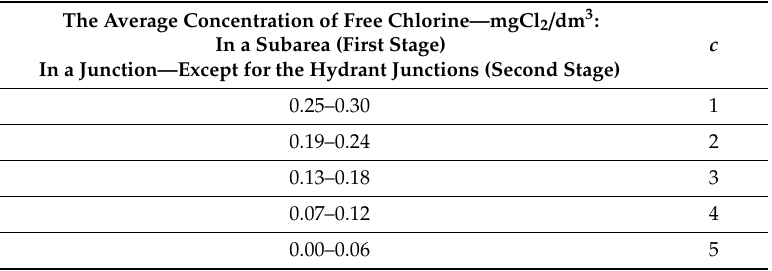
Table 2. Values of coe ffi cient c indicating the mean free chlorine concentration. The Average Concentration of Free Chlorine—mgCl 2 / dm 3